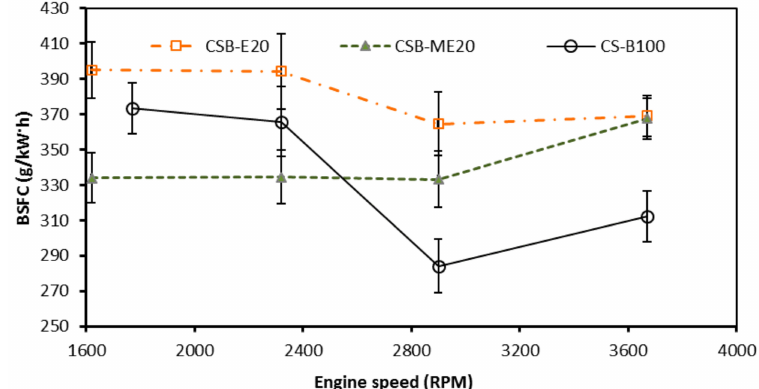
Figure 10. The relationship between engine speeds (rpm) and BSFC (g / kW · h) for CS-B100, CSB-E20 and